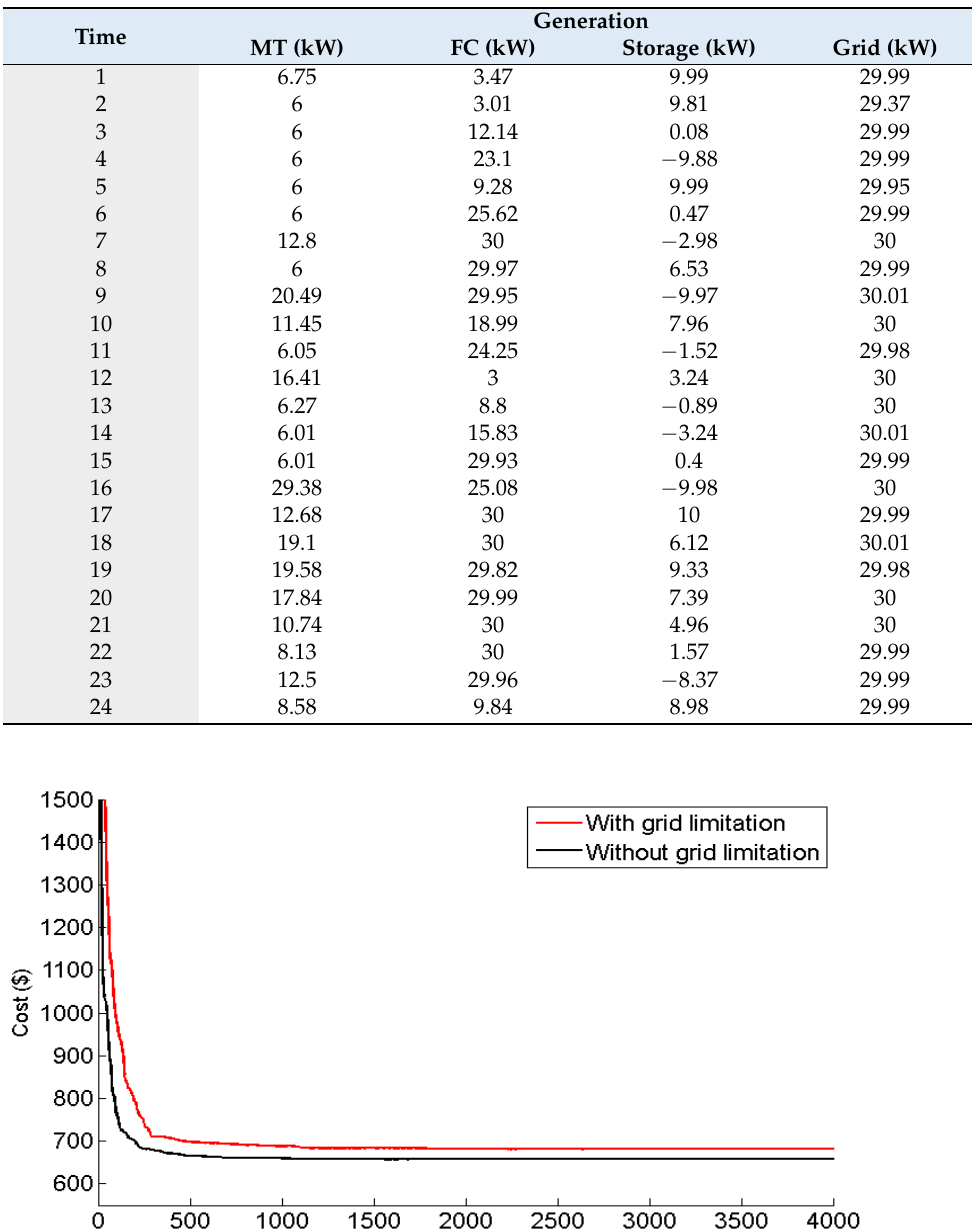
Table 19. Distribution of power between generating sources to reduce pollution with considering power exchange limitation (total pollution: 428.15 kg).